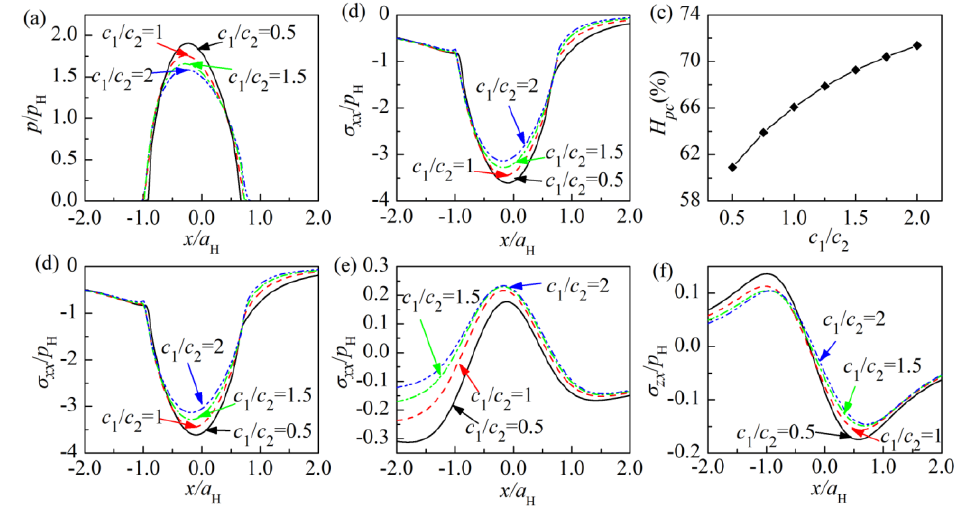
Figure 9. Effect of the coating volumetric heat capacity c 1 on: ( a ) contact pressure along x axis, ( b ) surface temperature rise along x axis, ( c ) frictional heat partition coefficient, ( d ) σ xx on the surface, ( e ) σ xx at the base of the coating, ( f ) σ zx on the interface.